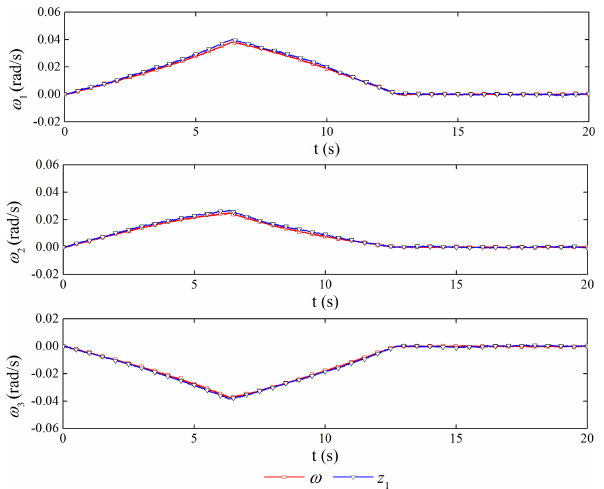
Figure 19. Control torque. Table 3. Parameters of the